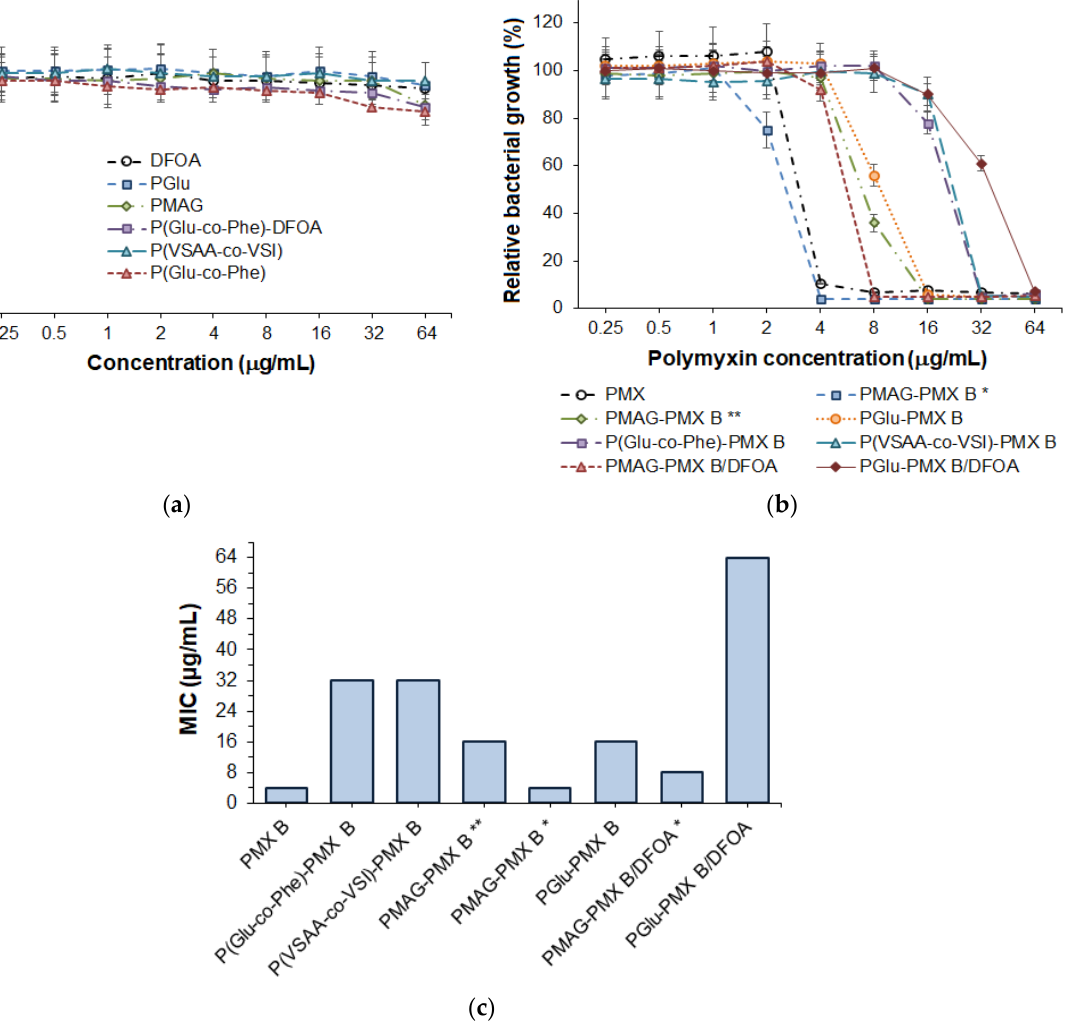
Figure 7. Antimicrobial activity of polymers and DFOA ( a ), and free and conjugated PMX ( b ) depending on concentration as well as the comparison of minimal inhibition concentration for different antibacterial samples ( c ) (* aldimine bonds (Schiff base) between polymer and PMX; ** reduced aldimine bonds). P. aeruginosa was cultured in 96-well plates with and without testing samples for 18 h, and then the optical density (OD) proportional to bacterial growth was measured at 630 nm. Relative bacterial growth (%) was determined as a ratio of the OD 630 in each concentration of the testing samples to OD 630 in the control (0 µ g/mL). Data are presented as the mean ± SD (n = 9). The best antimicrobial activity (4 µ g/mL), equal to the MIC of free PMX B, was observed for the PMAG–PMX B conjugate, where the antibiotic was bound to the polymer via an aldimine bond (Schiff base). Reduction of the aldimine bond contributed to a fourfold increase in the MIC (to 16 µ g/mL). This fact can be explained by the faster release of PMX B from PMAG-based conjugates with hydrolysable bonds. Reduced microbial